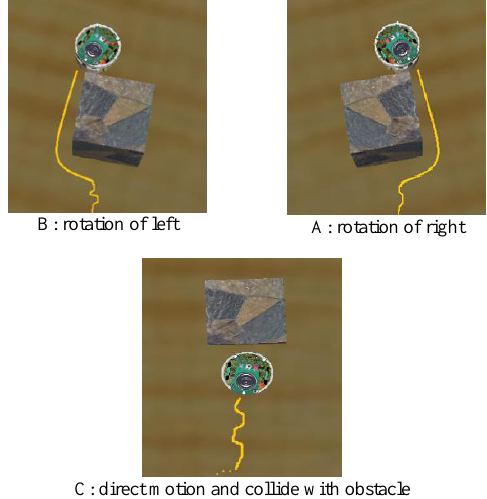
Figure 1. Bad influence of inconsistency in training data.